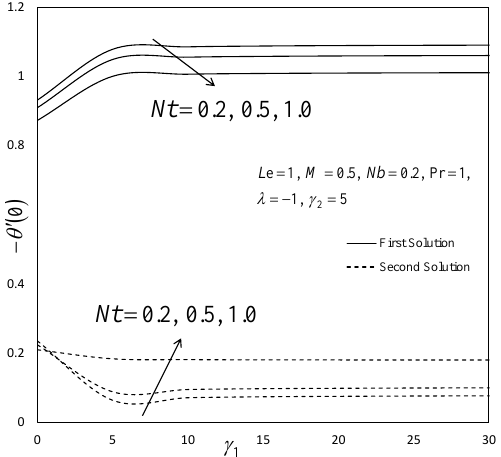
Figure 16. Variations of − θ (cid:48) ( 0 ) towards γ 1 for selected values of Nt .